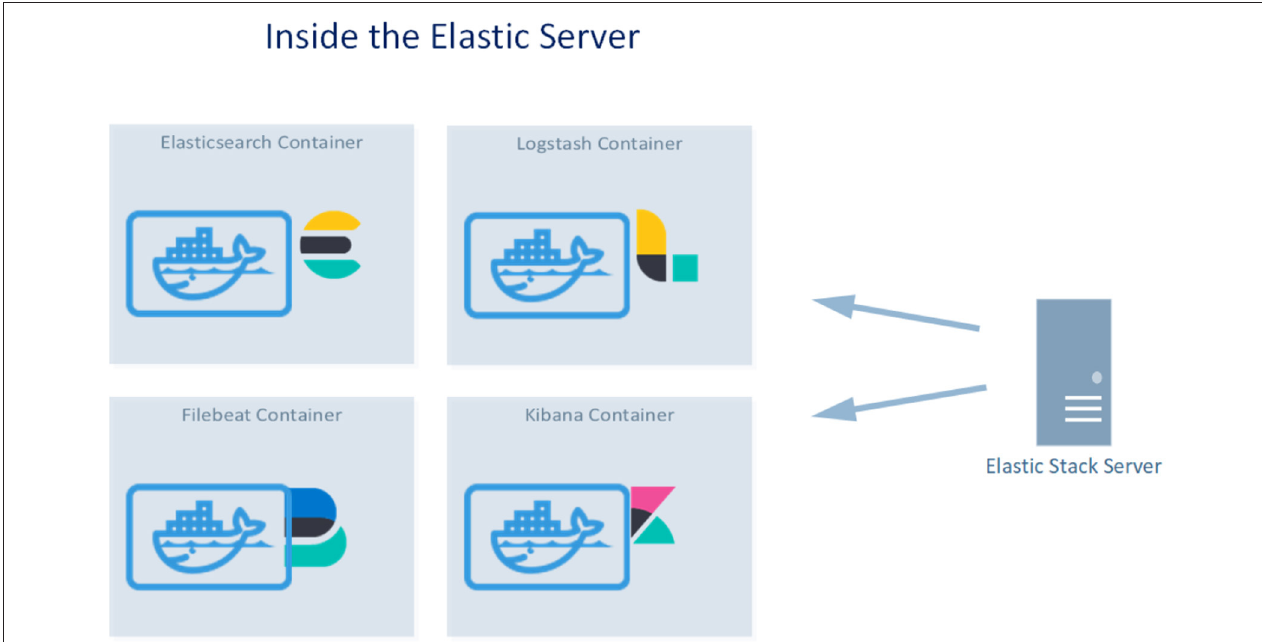
FIGURE 2 | The four docker containers running inside the Elastic Stack Server.